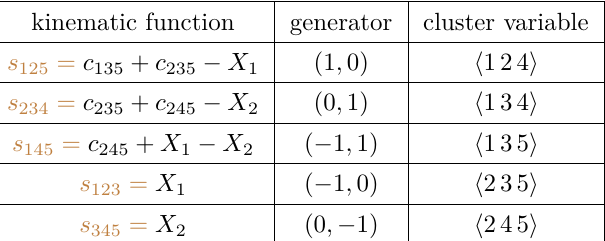
Table 1. The correspondence between kinematic functions, generators, and cluster variables for the C (3 , 5) polytope. Our conventions are summarized in section A, where we also review the definition and properties of the generalized Mandelstam variables s ijk